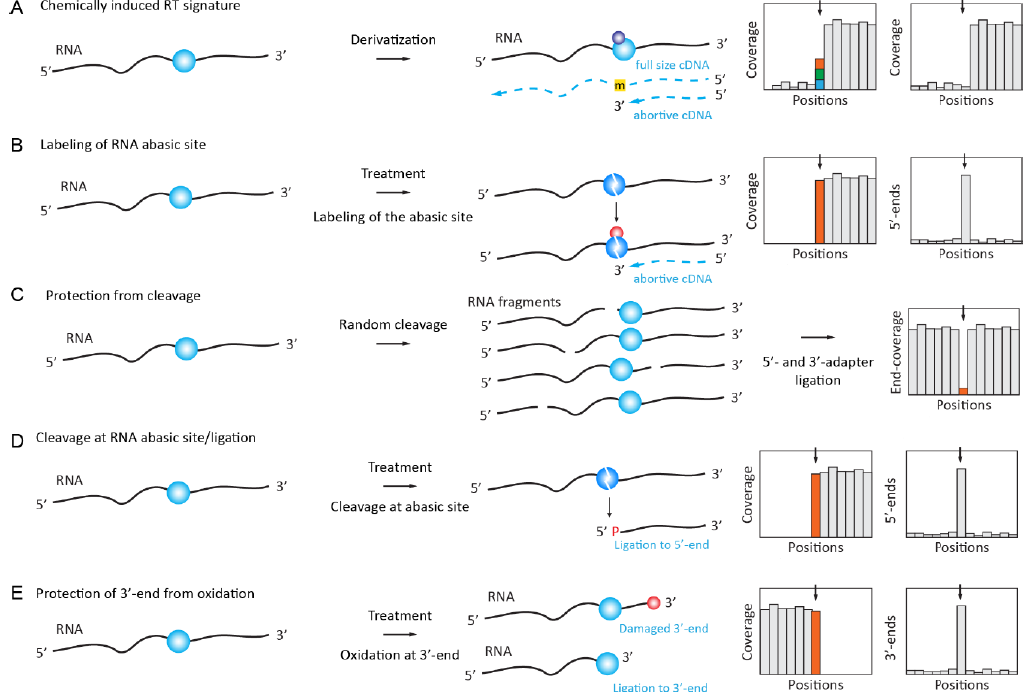
Figure 2. Detection of RNA modifications using chemically induced RT signatures or specific cleavage of the RNA ribose- phosphate backbone. ( A ): RNA treatment by a specific chemical reagent induces RT signature at the modified RNA residue in the form of a mis-incorporation profile (different nucleotides are shown by color) or abortive cDNA synthesis products. ( B ): chemical treatment selectively removes RNA-modified base by the cleavage of the N-glycosidic bond, releasing an RNA abasic site which can be labeled using an aldehyde-specific probe. ( C ): RNA modification induces the protection of the RNA backbone against cleavage (negative detection in RiboMethSeq and HydraPsiSeq protocols), thus excluding fragments starting and ending at the modified nucleotide. The signal is seen as a characteristic “gap” in 5’/3’-end coverage. ( D ): chemical treatment induces the cleavage of the RNA backbone and the release of a 5 ’ -phosphate, which is a competent in 5’ -adapter ligation. Panel ( E ): RNA modification (here, 3 ’ -terminal Nm residues released by random RNA fragmenta- tion) protects RNA from NaIO 4 oxidation, thus maintaining the efficient ligation of the 3’ adapter.